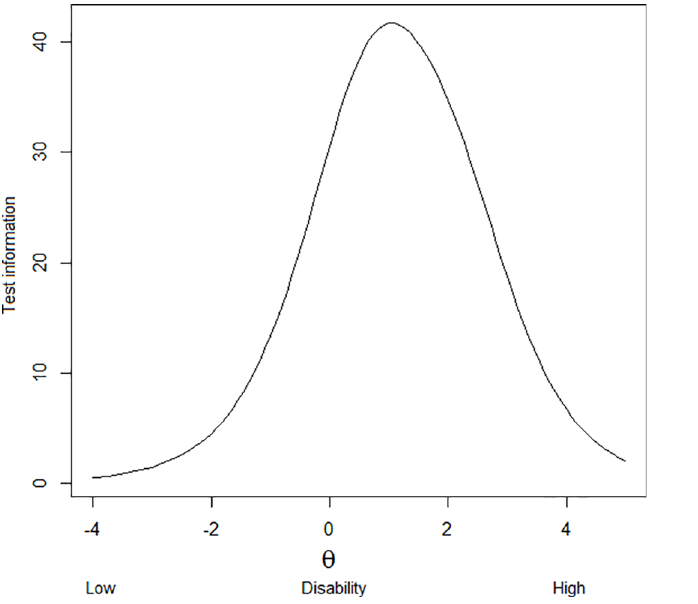
Fig 1. Test information curve of the